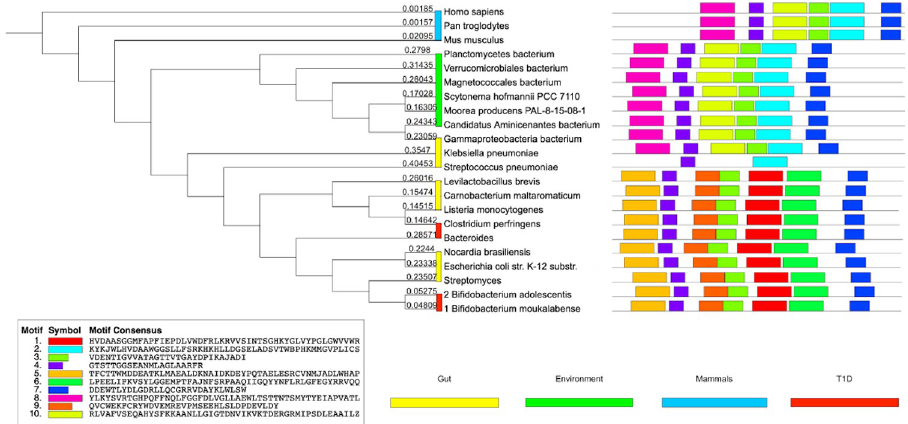
Fig 2. Motif discovery analysis of 19 bacterial GAD proteins and 3 animal GAD65 proteins to identify motifs conserved across various species and their functional relevance with GAD protein. Across all 22 GAD